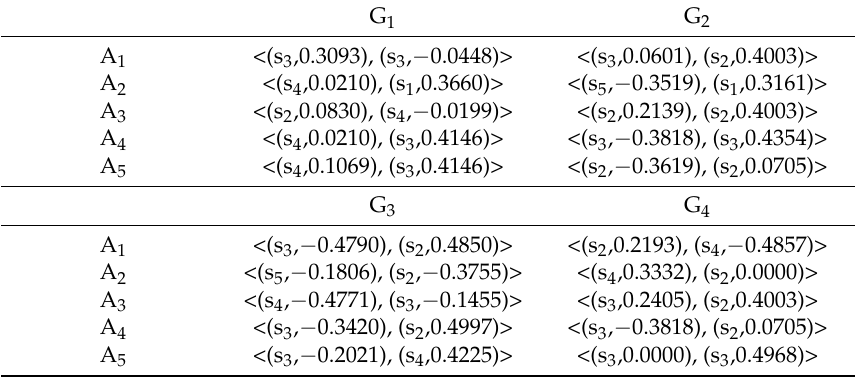
Table 4. The fused results by the 2TLPFNWA